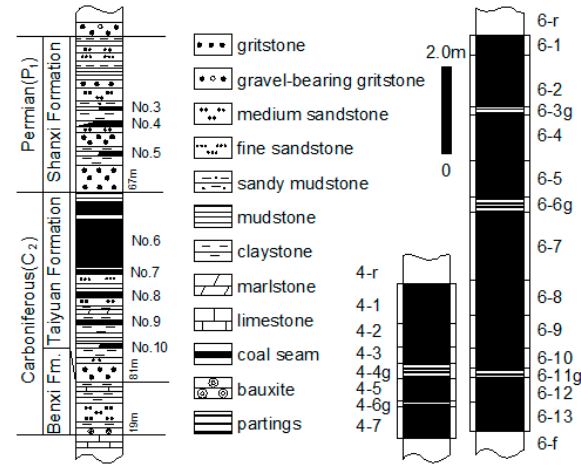
Figure 2. The coal seam column section. The left column map reproduced with permission from Wang et al. [40], published by Springer International Publishing AG,